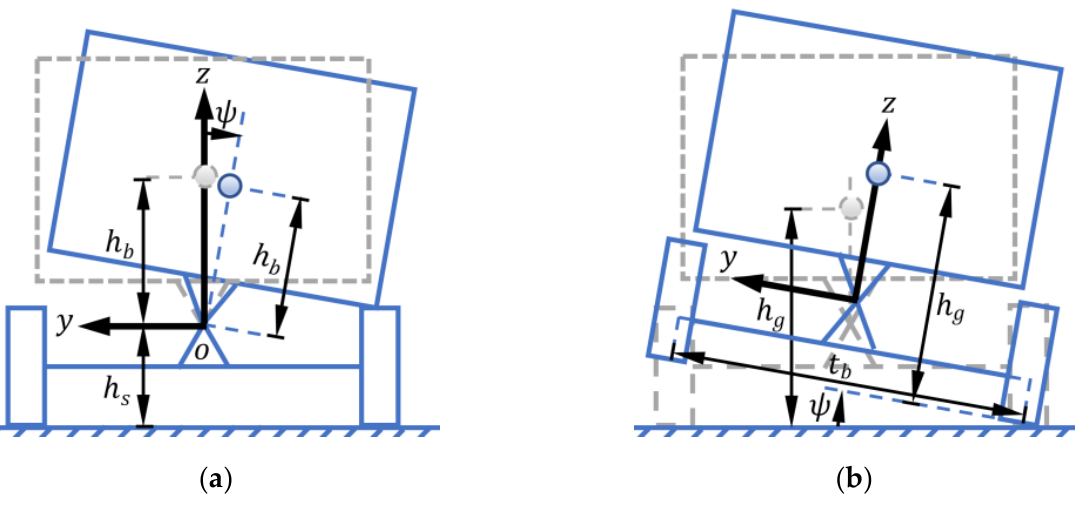
Figure 3. Roll dynamics model: ( a ) before the wheel lift-off; ( b ) after the wheel lift-off. The vehicle postures with gray broken lines express the vehicle motions without